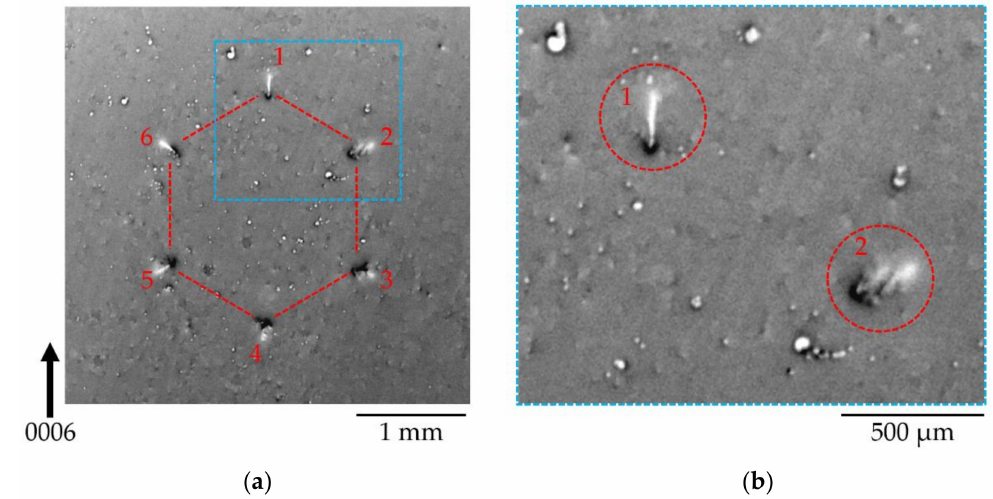
Figure 4. Back-reflection geometry 0006 SWB-XRT topograph showing ( a ) the hexagon labeled HCD-A in Figure 2b; ( b ) an enlarged view of corners 1 and